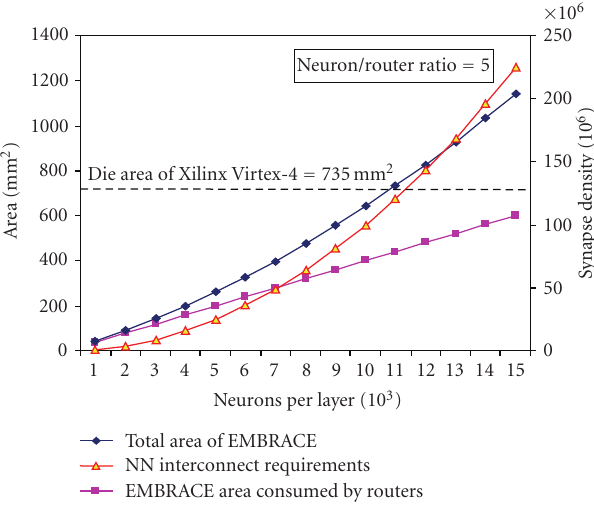
Figure 13: EMBRACE